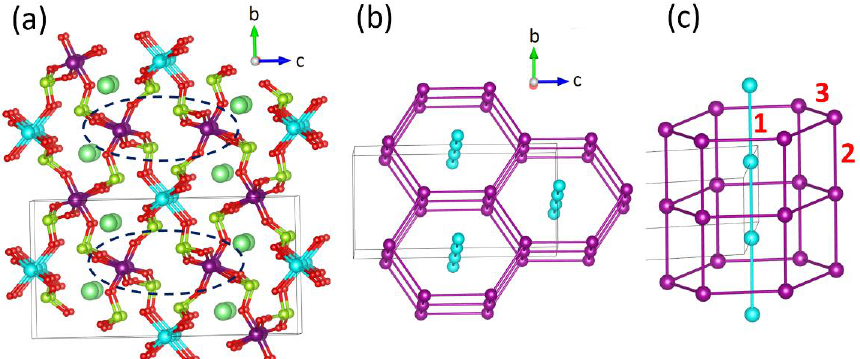
Figure 2. ( a ) The crystal structure of Ba 2 Mn 3 (SeO 3 ) 6 , where the Mn1 and Mn2 atoms are represented by cyan and violet spheres, respectively, and the Ba and Se atoms by large and small green spheres, respectively. The Mn2O 6 octahedra encircled by dashed ellipses have no interlinking by a SeO 3 pyramid. ( b ) The arrangements of the Mn1 and Mn2 atoms in Ba 2 Mn 3 (SeO 3 ) 6 . ( c ) One hexagonal prism of Mn 3+ ions containing one chain of Mn 2+ ions. The number 1 refers to the spin exchange J 1 of the chain of Mn 2+ ions, while 2 and 3 refer, respectively, to spin exchanges J 2 and J 3 of the hexagonal prism of Mn 3+ ions (see below).